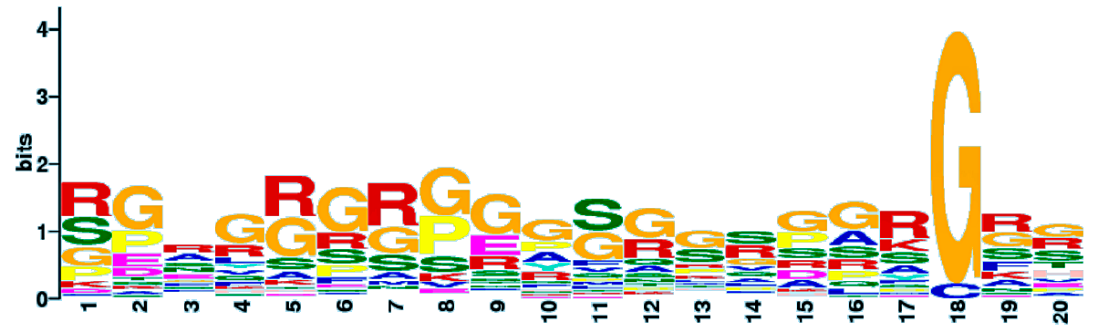
Figure 4. Novel interesting quadruplex interaction motif (NIQI) common to most quadruplex binding proteins.